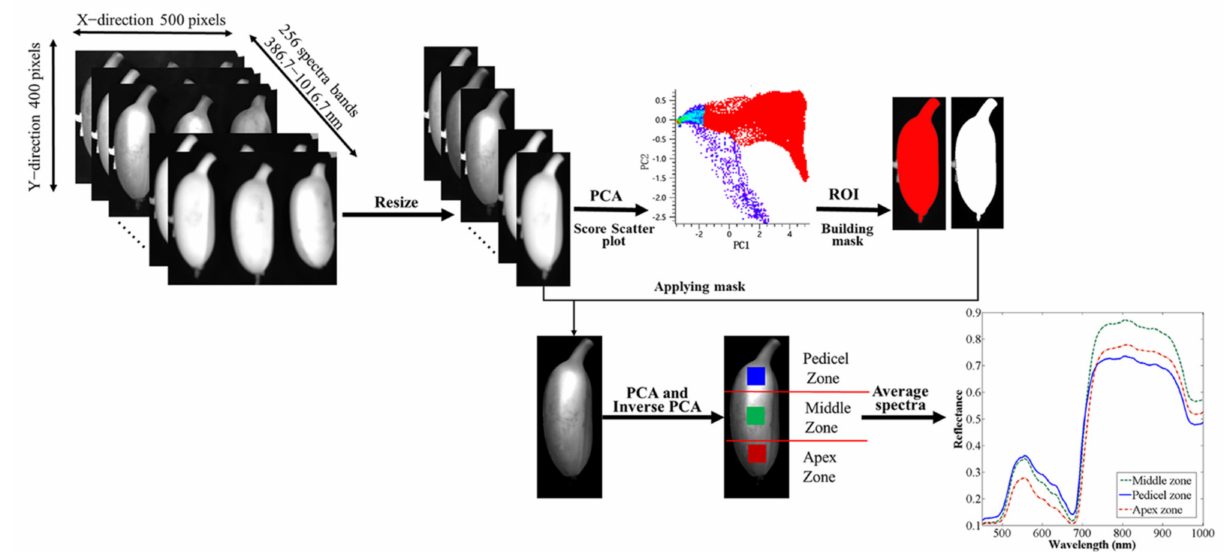
Figure 3. An illustration of spectra extraction from banana